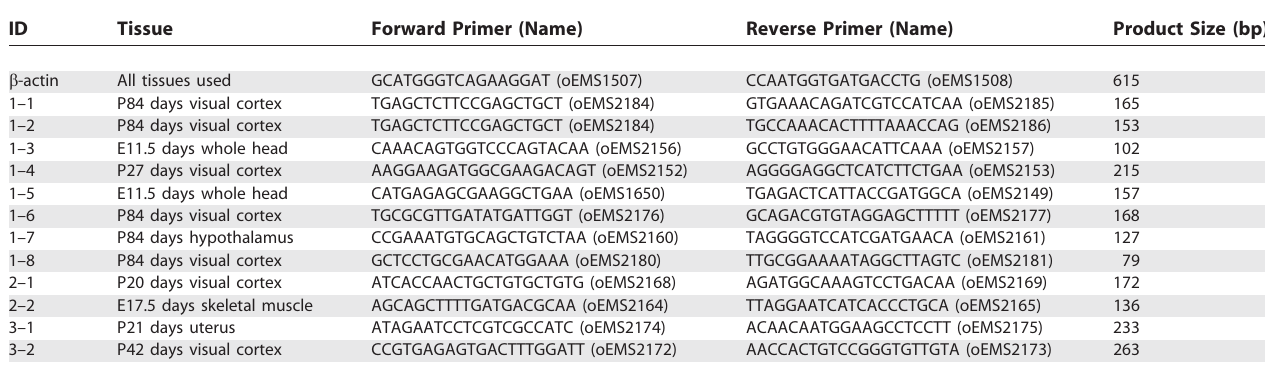
Table 3. RT-PCR Primers Were Designed for the Selected Candidates Based on Sequences of the Two Predicted Exons ID